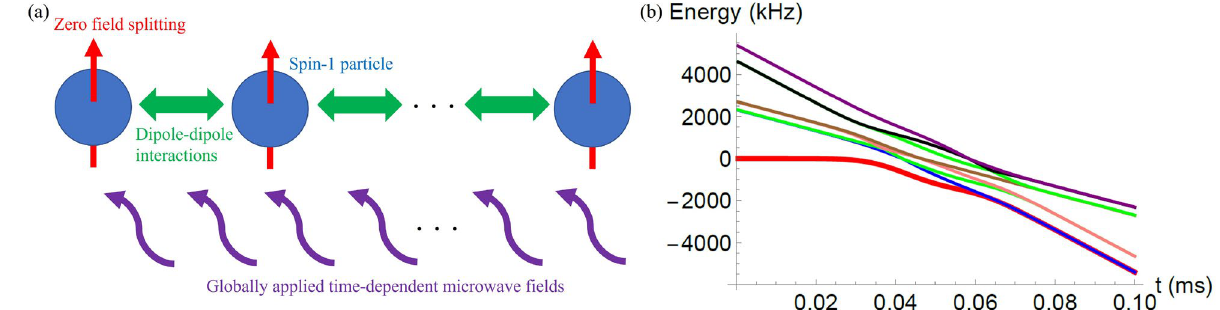
Figure 1. ( a ) Schematic of our proposal. Spin-1 particles with zero-field splitting are arranged in a one- dimensional chain. There are dipole-dipole interactions between the spin-1 particles. We globally apply time-independent microwave fields to implement the bifurcation-based quantum annealing. ( b ) We plot eigenenergies against the time with the unit of milliseconds where we adopt the Hamiltonian in the Eq.(9), which is derived by using a rotating wave approximation. The energy gap between the ground state and 2 π 400 kHz, 2 , D first excited state becomes smaller as t approaches to T . We set the parameters as L ′ 0 / = = 0.2 T , 1 kHz, E ( 1 ) 2 π 1.2 kHz, J 12 / 2 π 30 kHz, J 100 kHz, σ 2 π 60 kHz, B / 2 π E ( 1 ) x / 2 π x / ′ 12 / = = = = = = 0.1 T =